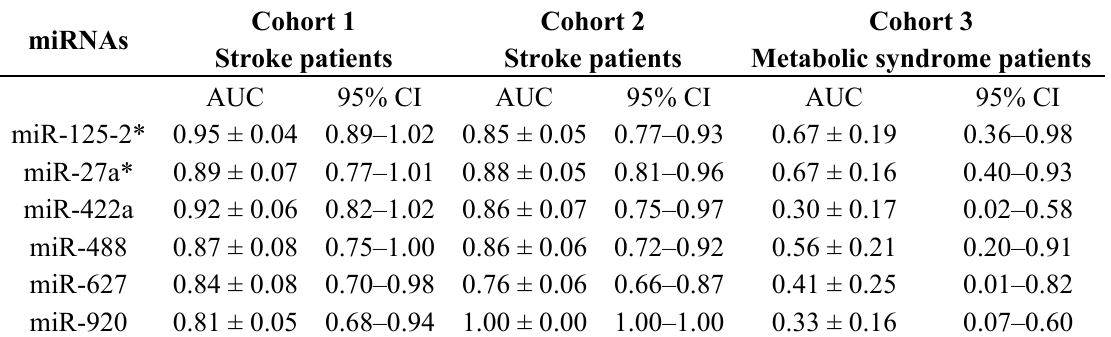
Table 2. Receiver operating characteristic (ROC) curve analysis. Values for area under the ROC curve (AUC) for selected miRNAs with biomarker potential as well as their 95% confidence intervals (CI) are